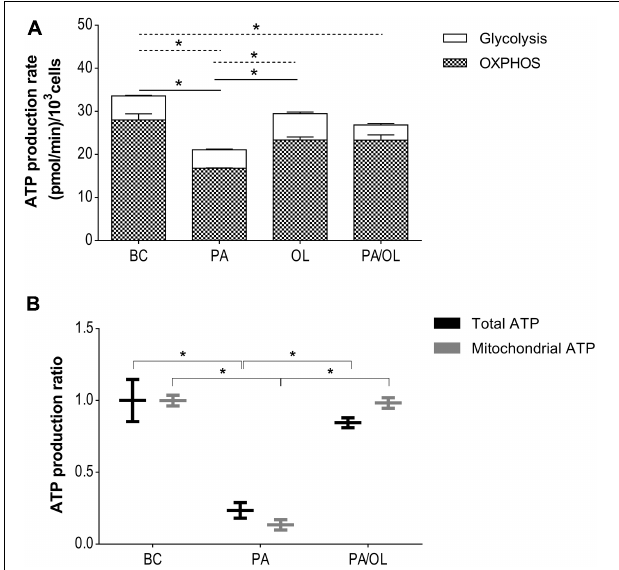
FIGURE 4 | Evaluation of energy balance. (A) Total ATP production rate estimated from the values of oxygen consumption (OCR) and the proton production rate (PPR). The production rate of total ATP in pmol/min and the distribution of the rate corresponding to the production by OXPHOS (stripes) and by the glycolytic pathway (white) is represented. Significant differences ( p < 0.05) are represented by continuous line (OXPHOS) and discontinuous line (glycolytic pathway). (B) Measurement of ATP production by luminescence, including both total and mitochondrial ATP. All data were obtained from three independent experiments, expressed as mean ratio in relation to BC ± deviation standard. * p < 0.05. BC = basal condition; PA = palmitic acid; OL = oleic acid; OXPHOS = oxidative